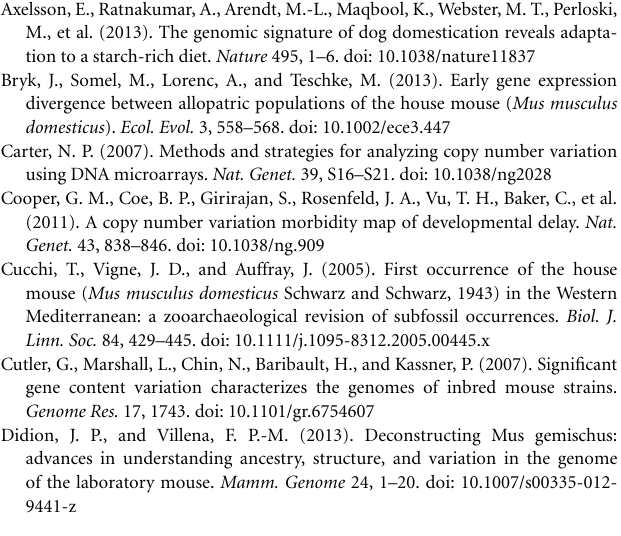
Table S1 | List of all genes on the custom CGH microarray. Table S2 | List of all CNVs found. (A) contains CNVs ordered by sample and genomic position and (B) contains CNVs ordered by Ensembl gene ID affected by CNVs. Table S3 | List of overlaps of identified CNVs with known Ensembl exons and introns. Table S4 | Results of gene ontology analysis. All significant categories ( p < 0 . 05 after FDR correction) are reported. Table S5 | Overview of CNVs differentiating the two populations. Table S6 | Primers used for microsatellite amplification. Table S7 | lnRH statistics for microsatellite length